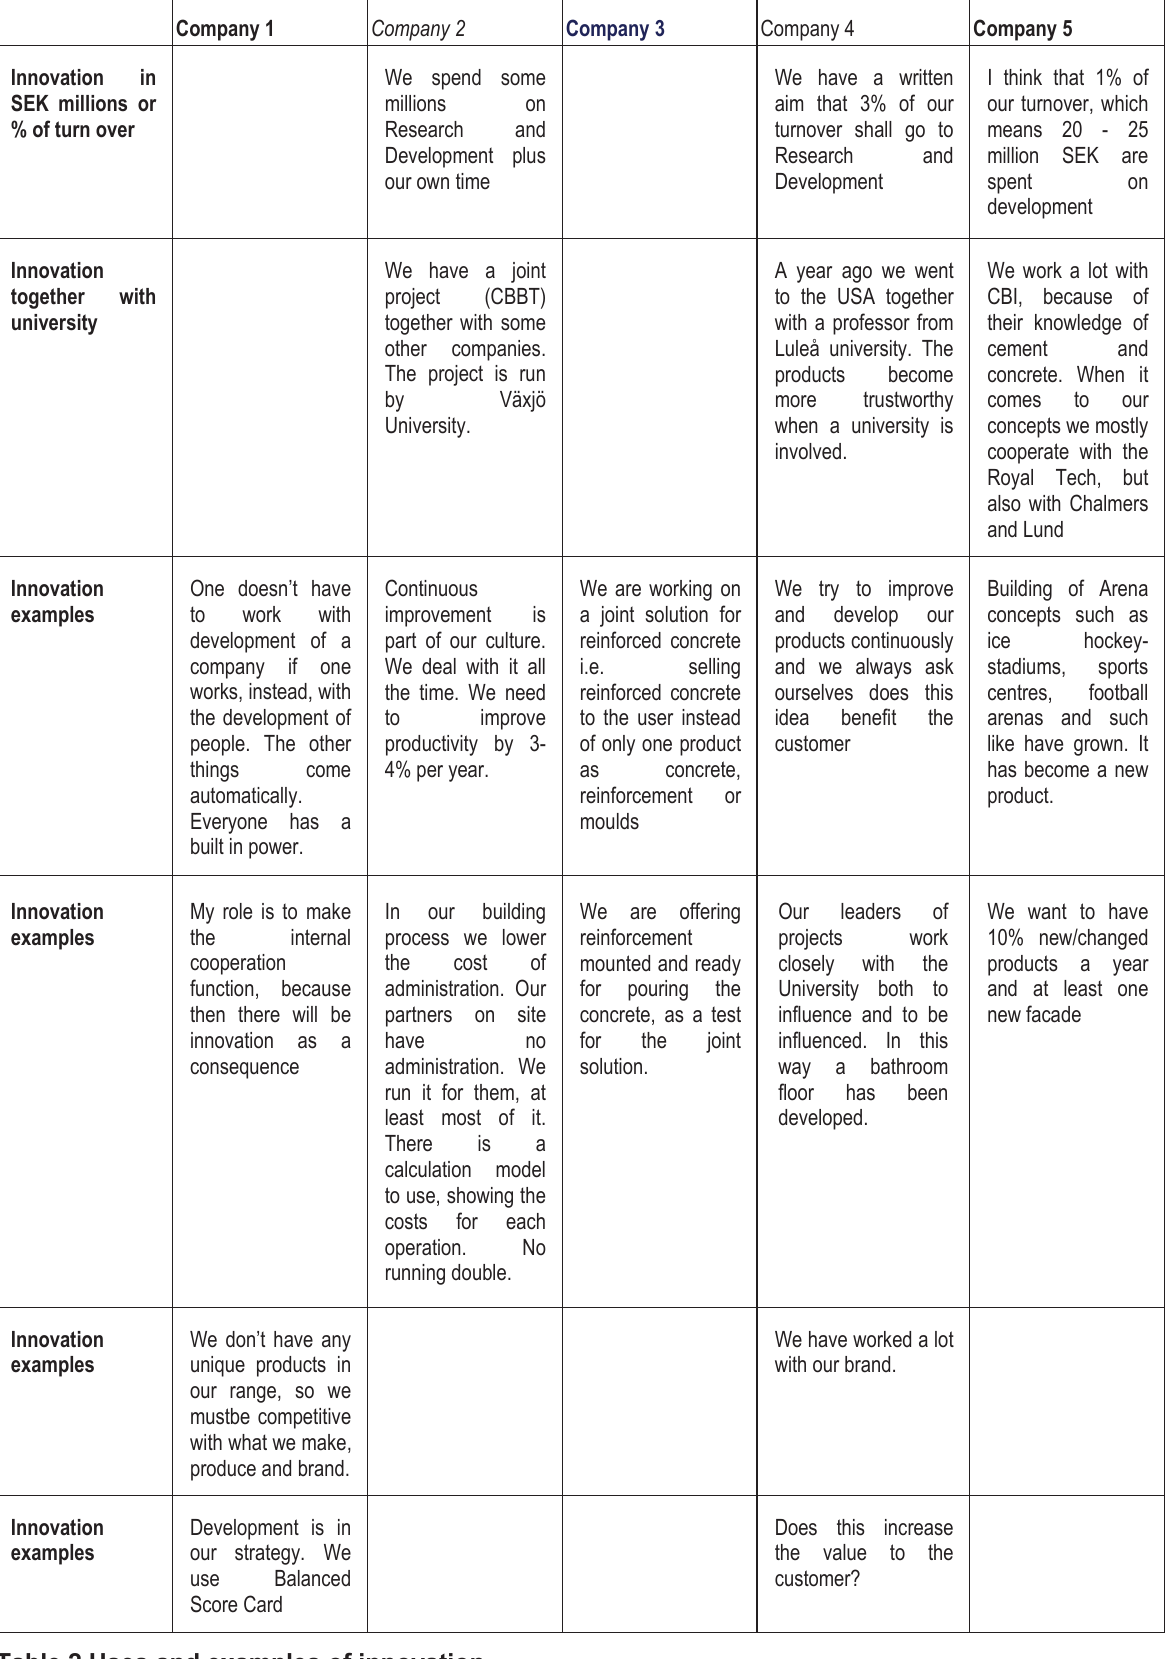
Table 2 Uses and examples of